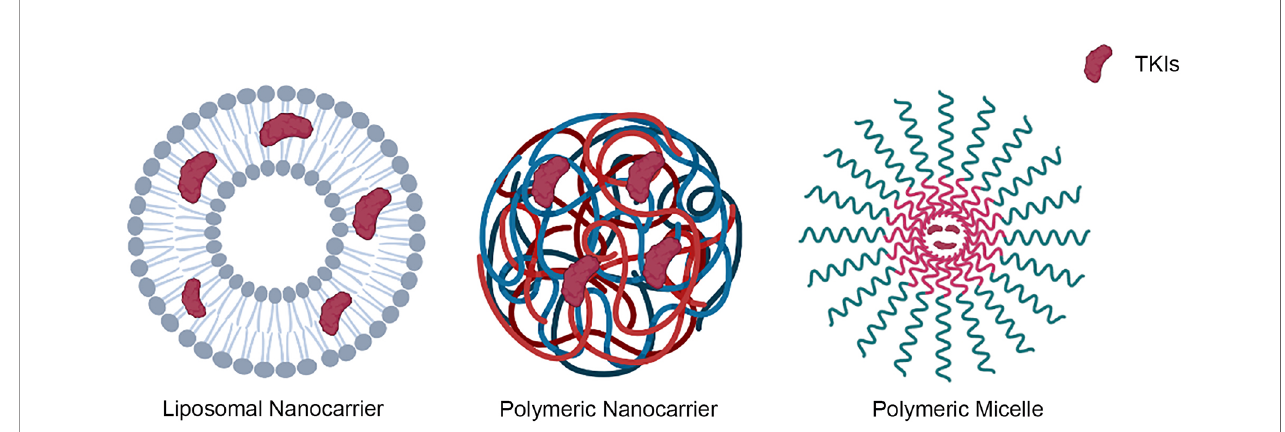
FIGURE 4 | Representative types of nanocarriers that were used in the delivery of TKIs, including liposomal, polymeric and polymeric micelle